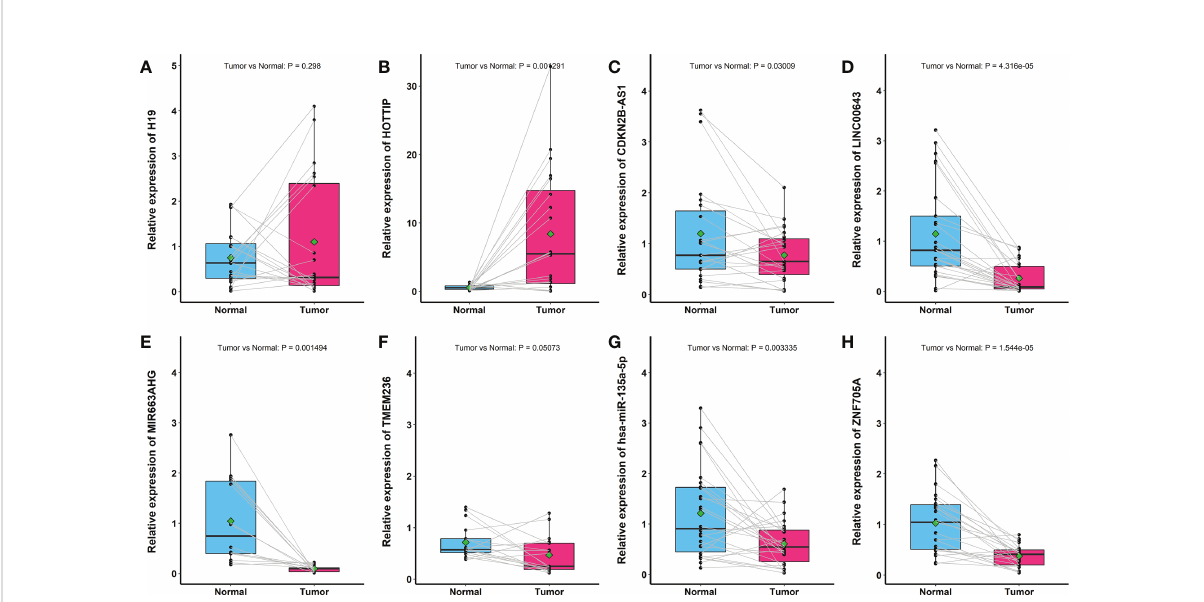
FIGURE 12 Reverse transcription – quantitative PCR result of eight RNAs expression in 30 pairs of gastric cancer tissues and adjacent non-tumor tissues. (A) H19. (B) HOTTIP. (C) CDKN2B-AS1. (D) LINC00643. (E) MIR663AHG. (F) TMEM236. (G) hsa-miR-135a-5p. (H)